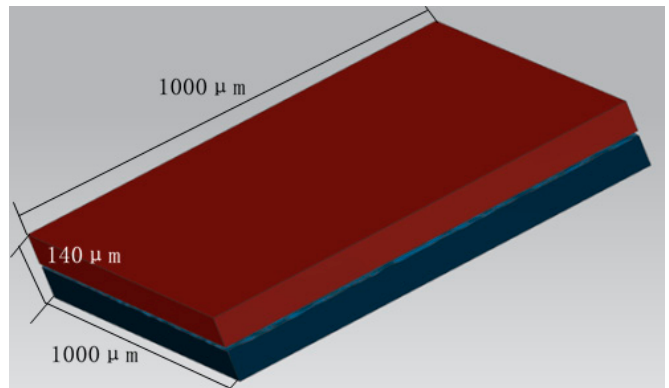
Figure 6. The contact model of seal rings.